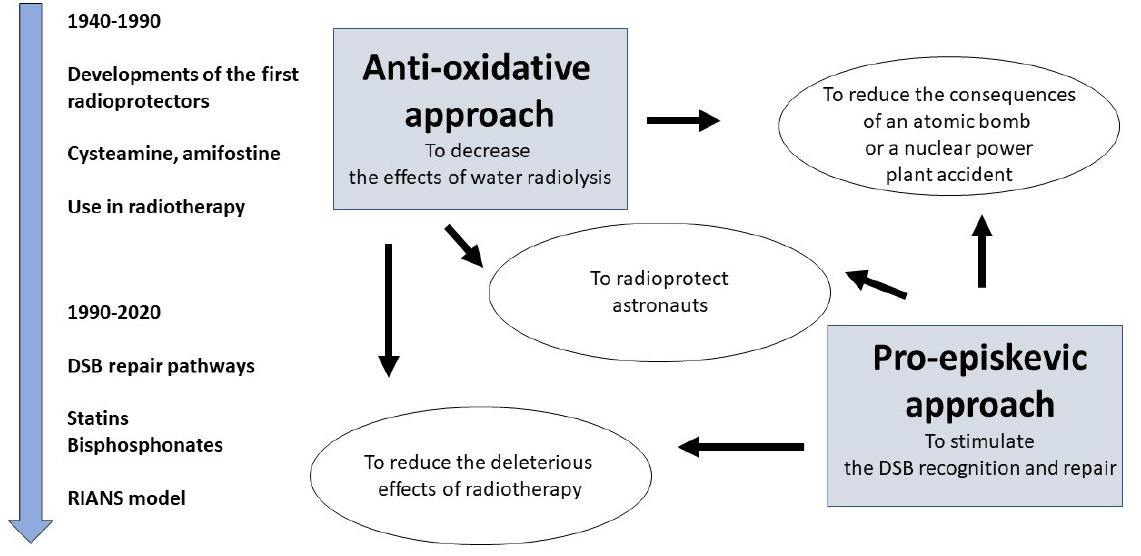
Figure 1. Schematic view of the two different approaches of radioprotection, their major princi ‐ ples and their historical milestones .